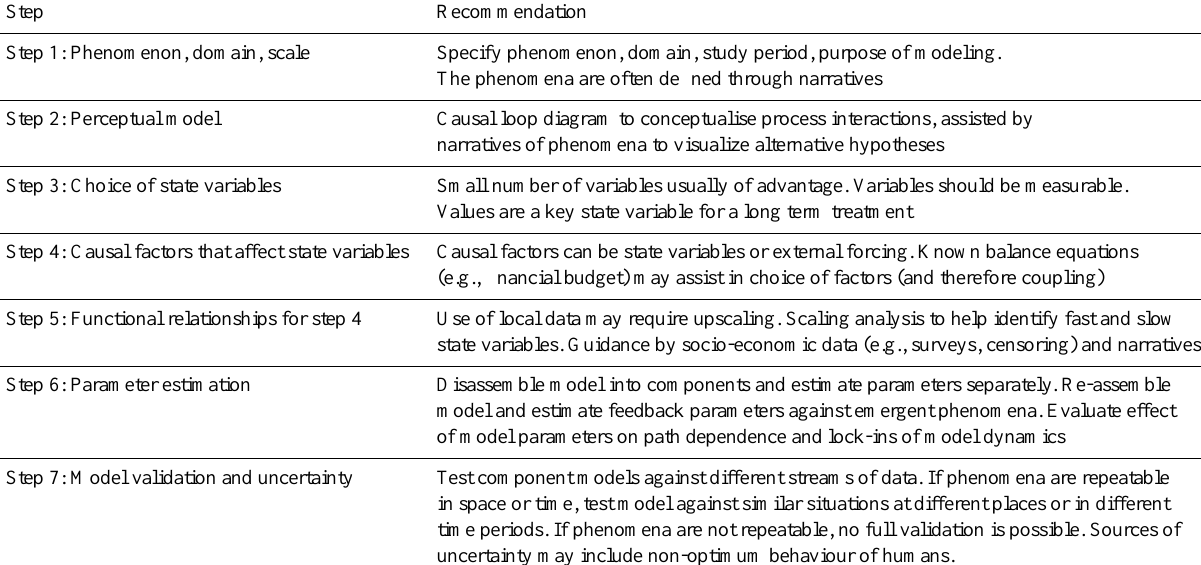
Table 2. Seven steps of framing and modeling hydrological vs coupled dynamic environmental vs socio-hydrological processes (shortened from Sivapalan and Blöschl,